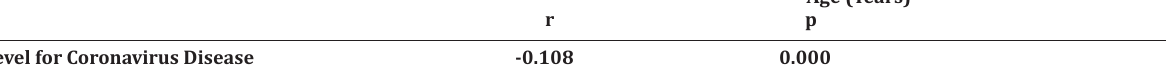
Relationship Between Knowledge Level for Coronavirus Disease and Age